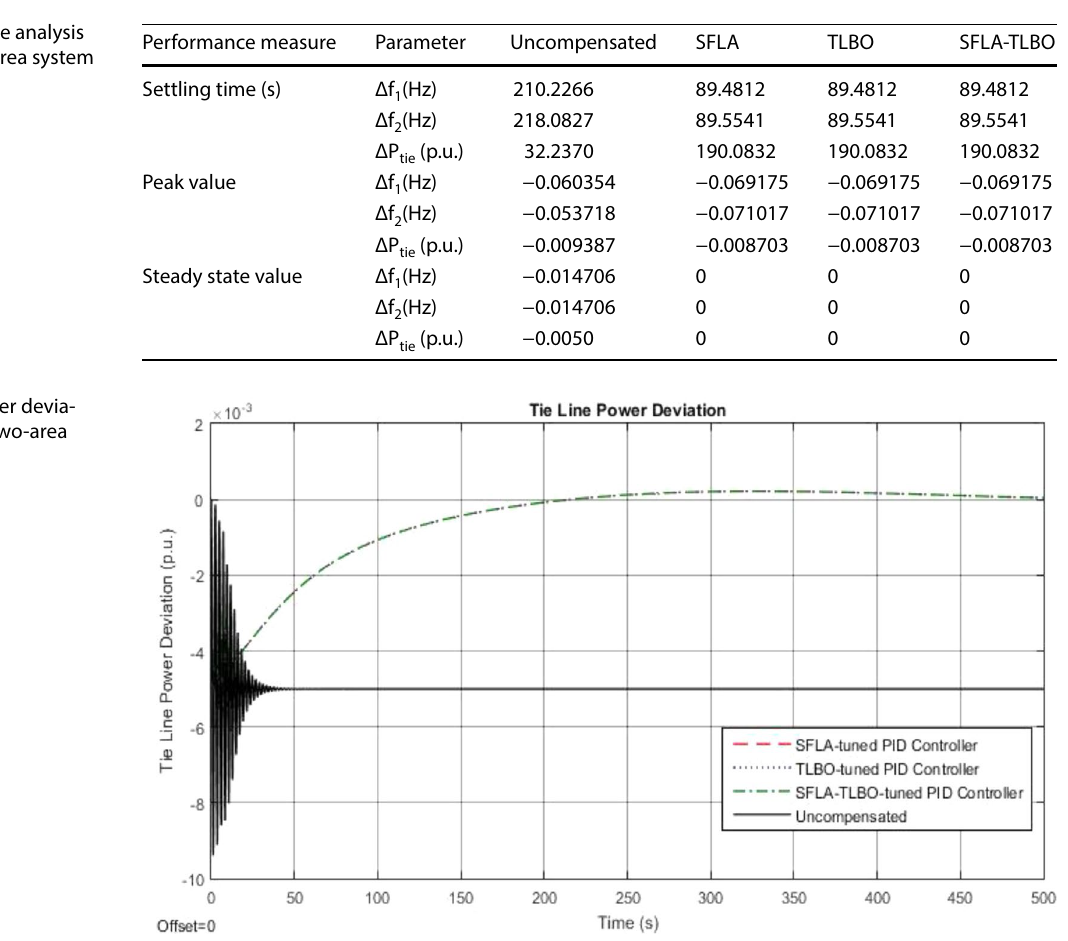
Table 6 Performance analysis for non-linear two-area